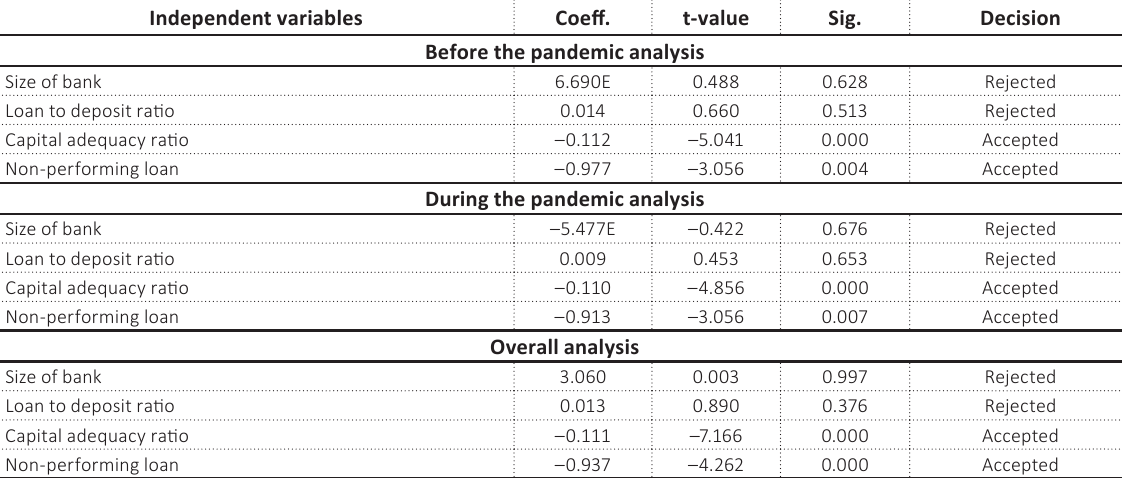
Table 2. Determinants of ROA before and during the pandemic